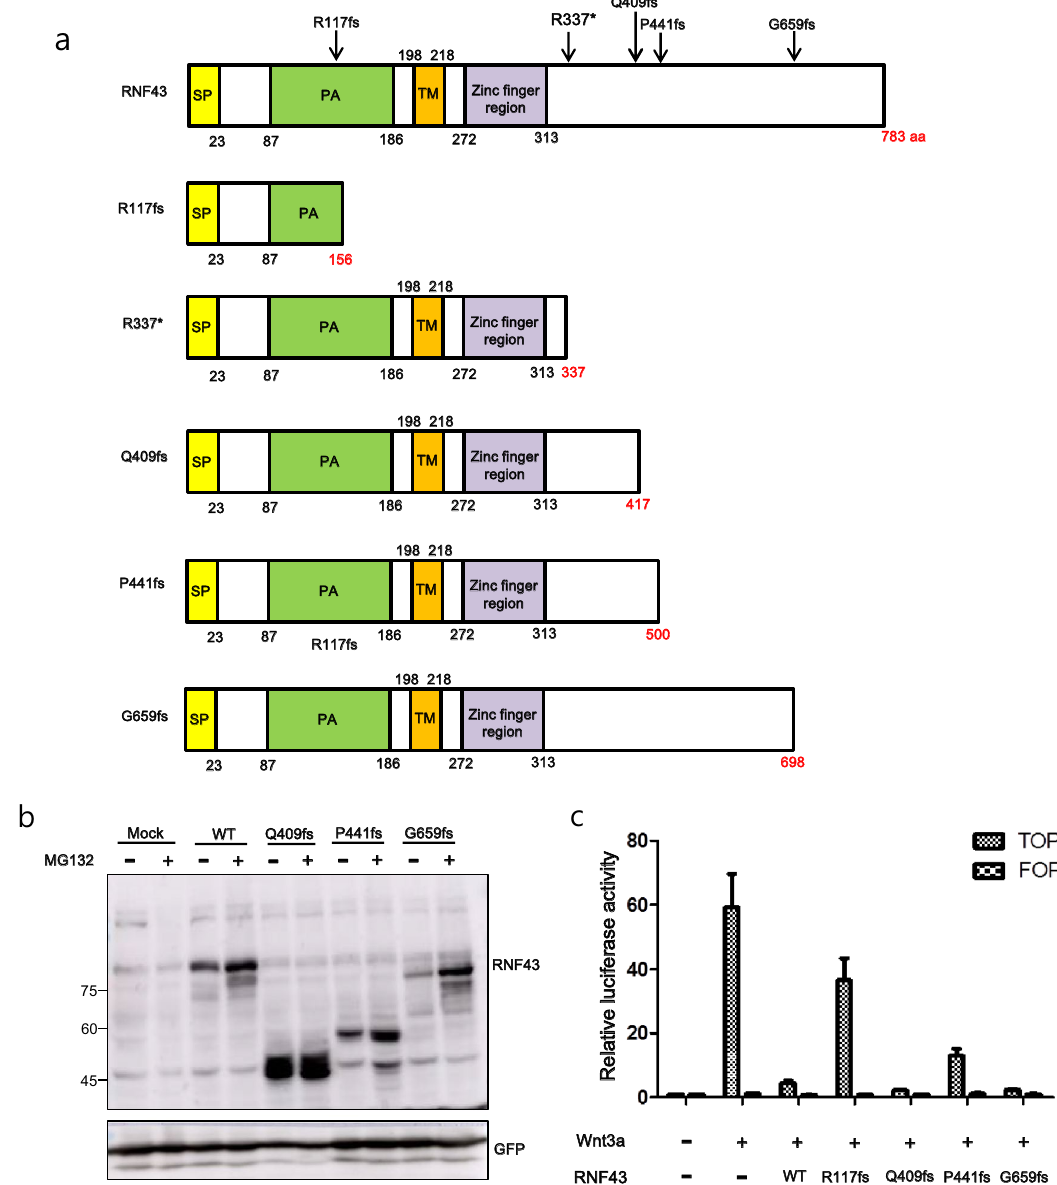
Figure 1. R117fs and P441fs mutants identified in GC patients lost the negative regulator function of RNF43 on Wnt/β-catenin signaling. ( a ) Distribution and types of RNF43 mutations. The conserved domain was from UniProt. SP, signal peptide; PA, protease-associated domain; TM, transmembrane. The a.a created by frameshift is represented in the domain. ( b ) Expression of WT RNF43 and mutant constructs. Ubiquitination of RNF43 constructs was evaluated upon MG132 treatment. ( c ) The effects of WT RNF43 and its mutants on Wnt/β- catenin signaling were examined using the TOP/FOP luciferase reporter assay. WT RNF43 suppressed the Wnt/β-catenin signaling induced by Wnt3A. R117fs and P441fs mutants lost the suppressor function of RNF43 in the Wnt/β-catenin signaling pathway. Q409fs and G659fs mutants exerted a negative regulatory function in WT